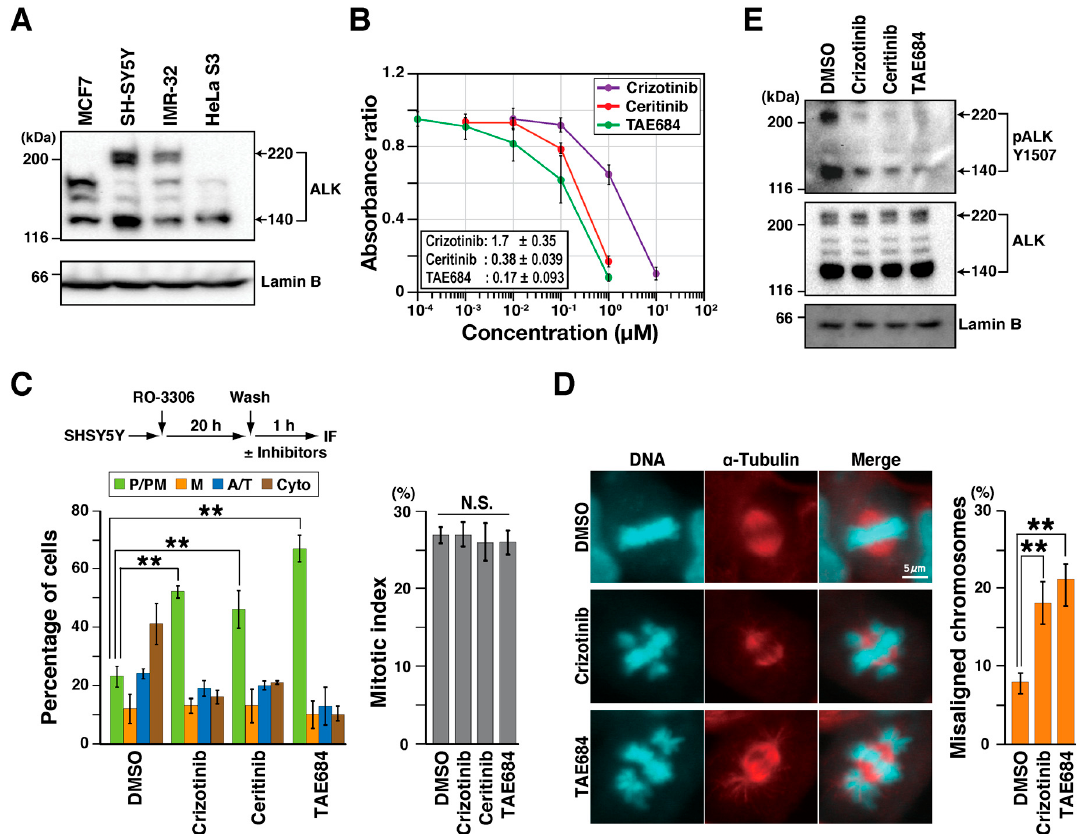
Figure 1. ALK inhibitors delay M phase progression. ( A ) Whole cell lysates were analyzed by western blotting with anti-ALK and anti-Lamin B (loading control) antibodies. ( B ) SH-SY5Y cells were treated with inhibitors for 2 days, and viable cells were determined by WST-8 assay. Relative values of absorbance to solvent control (dimethyl sulfoxide, DMSO) are shown as mean ± SD, calculated from three independent experiments. ( C ) SH-SY5Y cells were synchronized with 4 µM RO-3306 for 20 h. After release, cells were treated with 1 µM crizotinib, 0.5 µM ceritinib, and 0.3 µM TAE684 for 1 h and stained for α -tubulin and DNA. Based on microtubule and chromosome morphology, M phase cells were classified into four groups: prophase/prometaphase (P/PM), metaphase (M), anaphase/telophase (A/T), and cytokinesis (Cyto). The percentages of cells of each group (n > 246 in each experiment) and associated mitotic indices ( n > 453 in each experiment) are plotted as the mean ± SD, calculated from three independent experiments. ( D ) The number of cells with misaligned chromosomes was counted under a microscope, and their percentages are plotted as the mean ± SD of three independent experiments ( n > 246 in each experiment). Representative images of cells with misaligned chromosomes are shown; scale bar = 5 µm. The Tukey–Kramer multiple comparison test was used to calculate p values. ** p < 0.01; N.S., not significant. ( E ) SH-SY5Y cells were treated with inhibitors in the same concentrations as in ( C ) for 1 h, and whole cell lysates were analyzed by Western blotting using anti-pALK-Y1507 and anti-ALK antibodies. Lamin B was incorporated as a loading control.